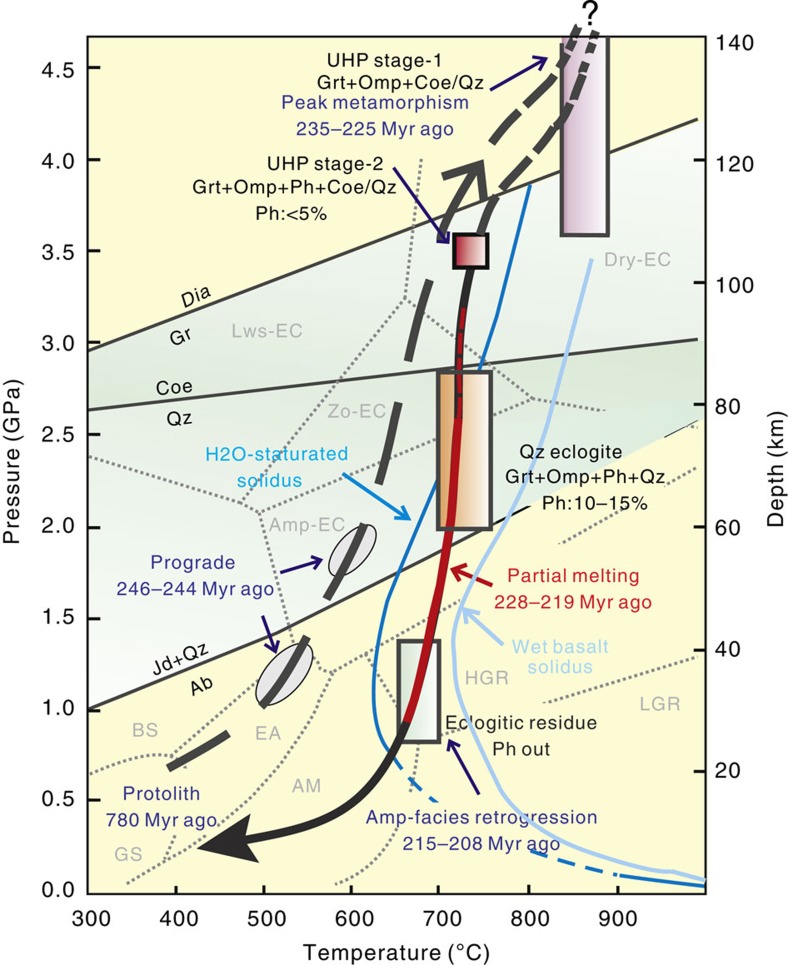
P–T–t path of the UHP eclogite and eclogitic residue in the Yangkou and General's Hill, Sulu Belt.Ages of prograde, peak metamorphism and amphibolite-facies retrogression stages are from ref. 15. The ages of the protolith and partial melting are from this study (original data shown in Supplementary Data Set 4). Eclogite from UHP stage-1 contains no phengite; however, phengite in eclogite from UHP stage-2 to quartz eclogite facies rises to 5–15%. These three types of eclogite samples were taken from Yangkou Bay, eclogitic residue sample is taken from General's Hill. Our P–T estimation is based on the geobarometer of Waters & Martin41 and the geothermometers of Ravna40 and Green & Hellman42. Original EMP (electron microprobe) data are shown in the Supplementary Data Set 3. The P–T–t path is modified from Zhang and Liou60; Liu and Liou13. Petrogenetic grids, subdivision of eclogite-facies and reaction curves diamond=graphite, coesite=quartz and jadeite+quartz=albite are from Bundy61, Oh and Liou62, Holland63 and Bohlen and Boettcher64, respectively. Dark blue curve of the water-saturated basalt solidus is from Lambert & Wyllie65 and light blue curve of the wet solidus is from Schmidt & Poli66. AM, amphibolites facies; AM, amphibolites facies; Amp-EC, amphibole eclogite facies; BS, blueschist facies; Dry-EC, dry eclogite facies; EA, epidote amphibolites faciesl; GS, greenschist facies; HGR, high-pressure granulite facies; LGR, low-pressure granulite facies; Lws-EC, lawsonite eclogite facies; Zo-EC zoisite eclogite facies.